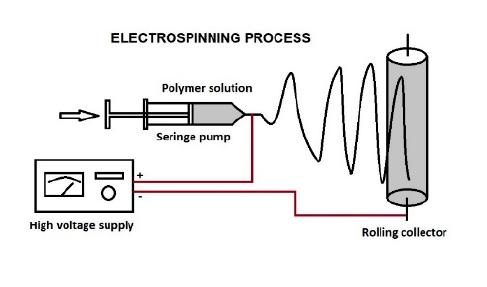
Figure 1. Electrospinning process